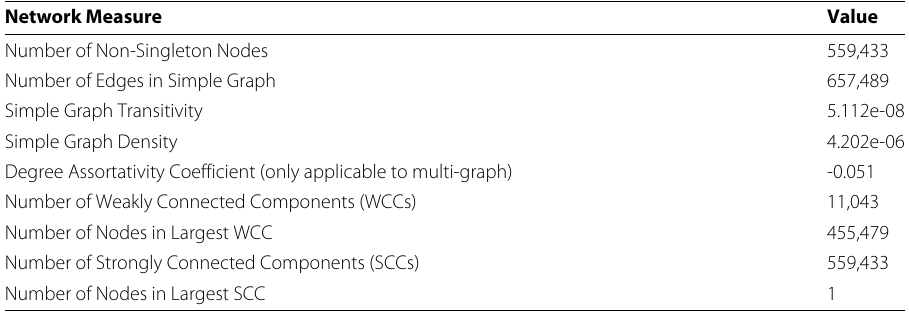
Table 2 Network measures on the Panama multi-network. Density, and other such metrics, were computed with respect to non-singleton nodes e.g., the density of the simple graph underlying the Panama multi-network is 657,489/(559,433*559,432/2) which is approximately 4.202e-06 (as reported below). Even among the non-singleton portion of the network, there are no non-singleton strongly connected components; hence, the total number of strongly connected components is simply equal to the number of non-singleton nodes (i.e. the number of nodes in the largest strongly connected component is simply 1) Network Measure Value Number of Non-Singleton Nodes 559,433 Number of Edges in Simple Graph 657,489 Simple Graph Transitivity 5.112e-08 Simple Graph Density 4.202e-06 Degree Assortativity Coefficient (only applicable to multi-graph) -0.051 Number of Weakly Connected Components